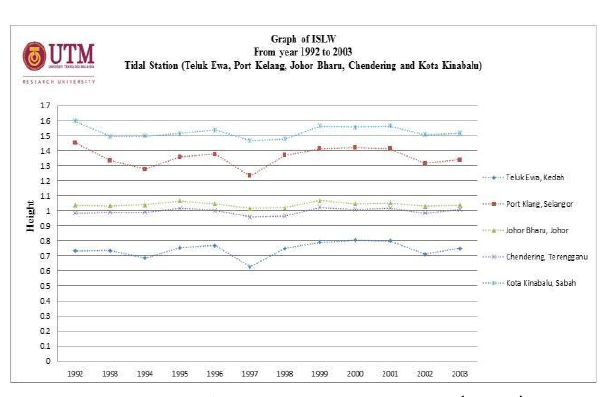
Figure 13. Graph of Lowest Astronomical Tide (LAT)